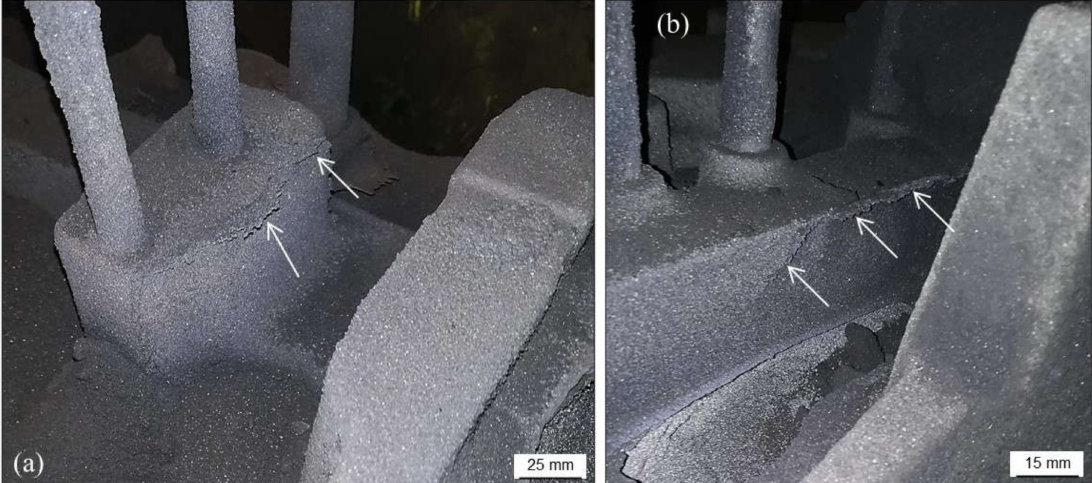
Figure 30. Veining in two different areas ( a , b ) of a grey iron engine block produced with green sand